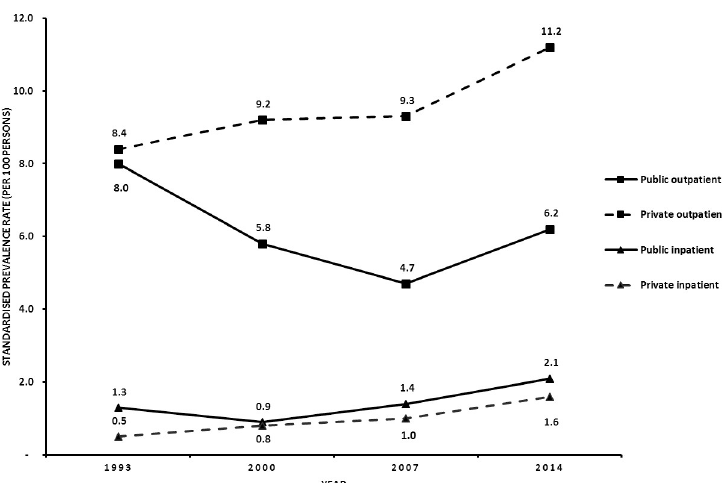
Fig 1. The standardised prevalence rate of healthcare utilisation for all types of healthcare, 1993–2014.